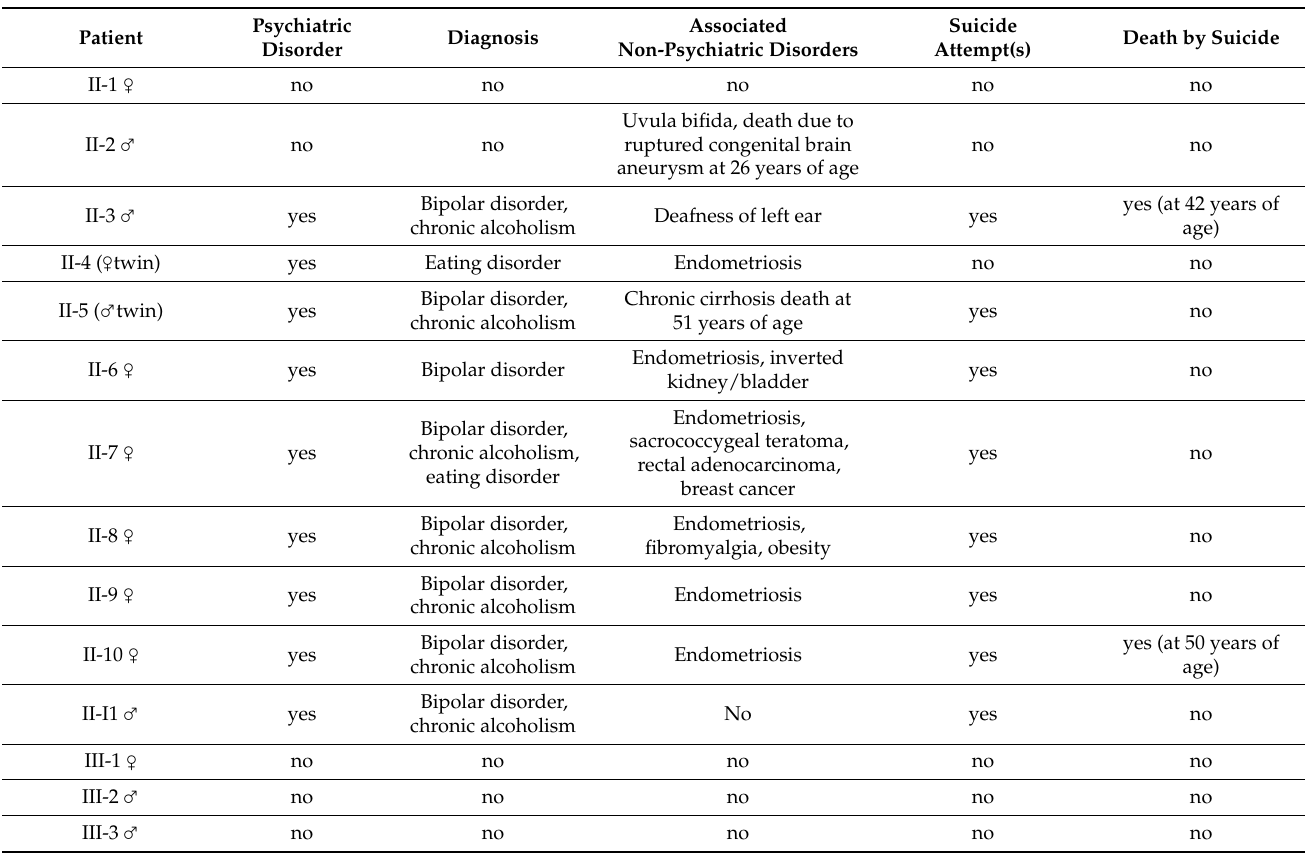
Table 1. Psychiatric disorders (columns 2–3) and comorbidities (column 4) diagnosed in the members of the informative family (column 1) whose mother took DES for 3 months after each delivery (therefore, II-1 was not exposed): 11 children (second generation: II-1 to II-11), born from 1956 to 1971, 27 grandchildren (third generation: III-1 to III-27) born from 1979 to 2004, and 11 great-grandchildren (fourth generation: IV-1 to IV-11) born from 2002 to 2020. The diagnosed psychiatric disorders are listed in column 3. In the second generation, eight children had bipolar disorders and a history of suicide attempts and/or completed suicide (columns 5 and 6), and two had eating disorders. Nine children also had comorbidities. In the third generation, three boys had ASD, and four girls had bipolar disorder. Among the great-grandchildren, one boy (born in 2008) has ASD and dyspraxia without any comorbidities. : male; : female;/: too young to be ♀ ♂